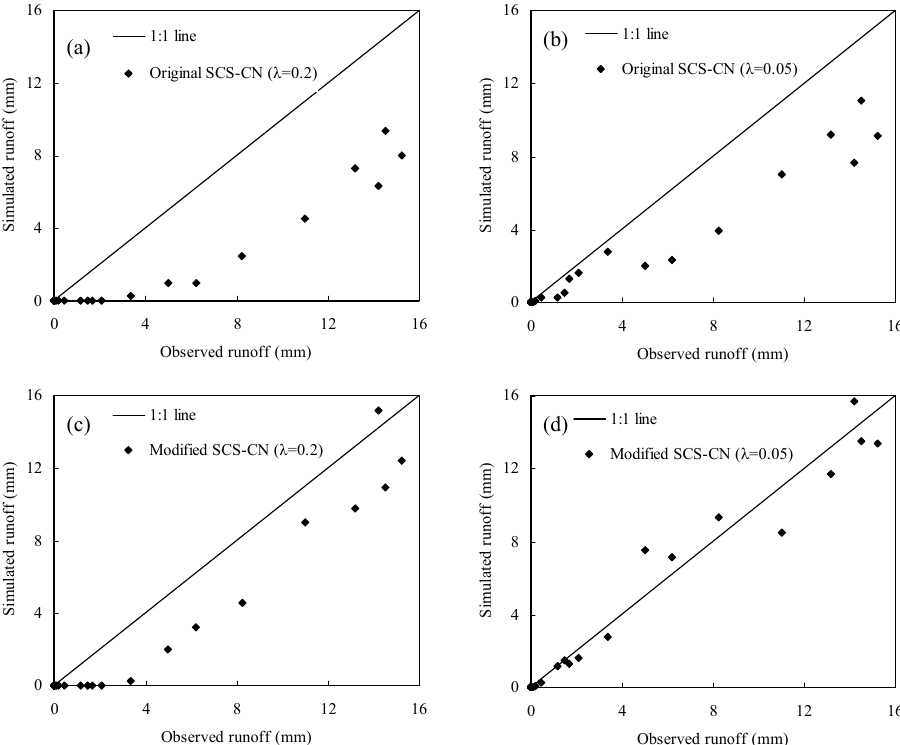
Fig. 5. Comparison between observed and predicted event runoff using (a) original SCS-CN ( λ = 0 . 2), (b) original SCS-CN ( λ = 0 . 05), (c) modified SCS-CN ( λ = 0 . 2) and (d) modified SCS-CN ( λ = 0 . 05) models for Group 3 runoff plots. and the modified SCS-CN model ( λ = 0 . 2) do. The EF val- ues of the modified SCS-CN model ( λ = 0 . 05) are 0.899 for Group 1 plot, 0.892 for Group 2 plot, and 0.879 for Group